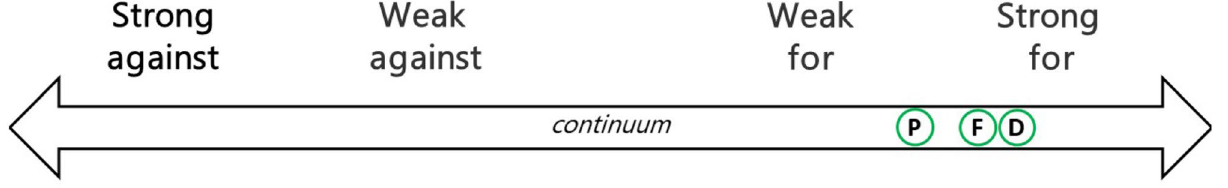
Figure 1. Treatment recommendation strength. The strength of a recommendation of a clinical procedure ranges in a continuum divided into categories and reflects the extent to which a guideline panel is confident that desirable effects outweigh undesirable effects. The results of the present meta-analysis indicate depression (D), fatigue in multiple sclerosis (F), and pain (P) as conditions in which the GRADE recommendation of tDCS treatments ranges between moderate and strong.